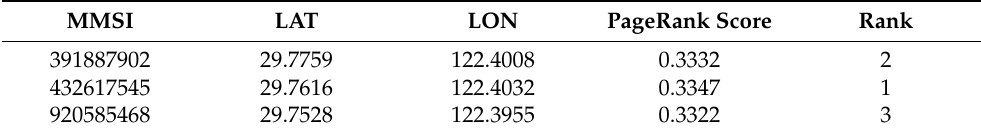
Figure 17. Multi-ship encounter relationship graph based on the coordinates of vessels. Table 5. Multiple ships collision risk